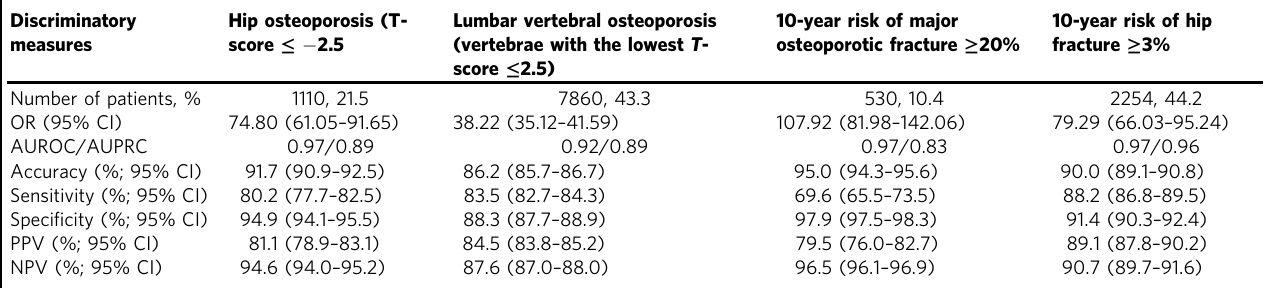
Table 3 Discriminatory performance (%) of the predicted BMD to classify hip/lumbar vertebral osteoporosis and high-risk groups for major osteoporotic or hip